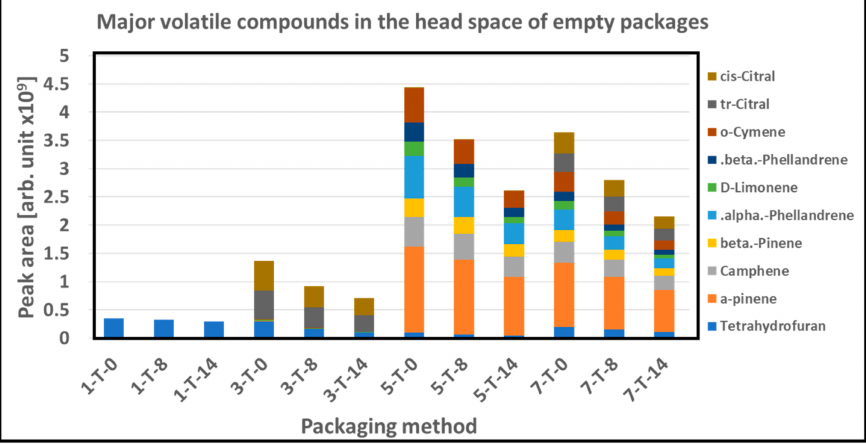
Figure 8. Major volatile compounds in the head space of empty packages with PC 1, 3, 5, and 7 with storage time of 0, 8, and 14 days. (x-T-y; x = packaging method, y = storage time in